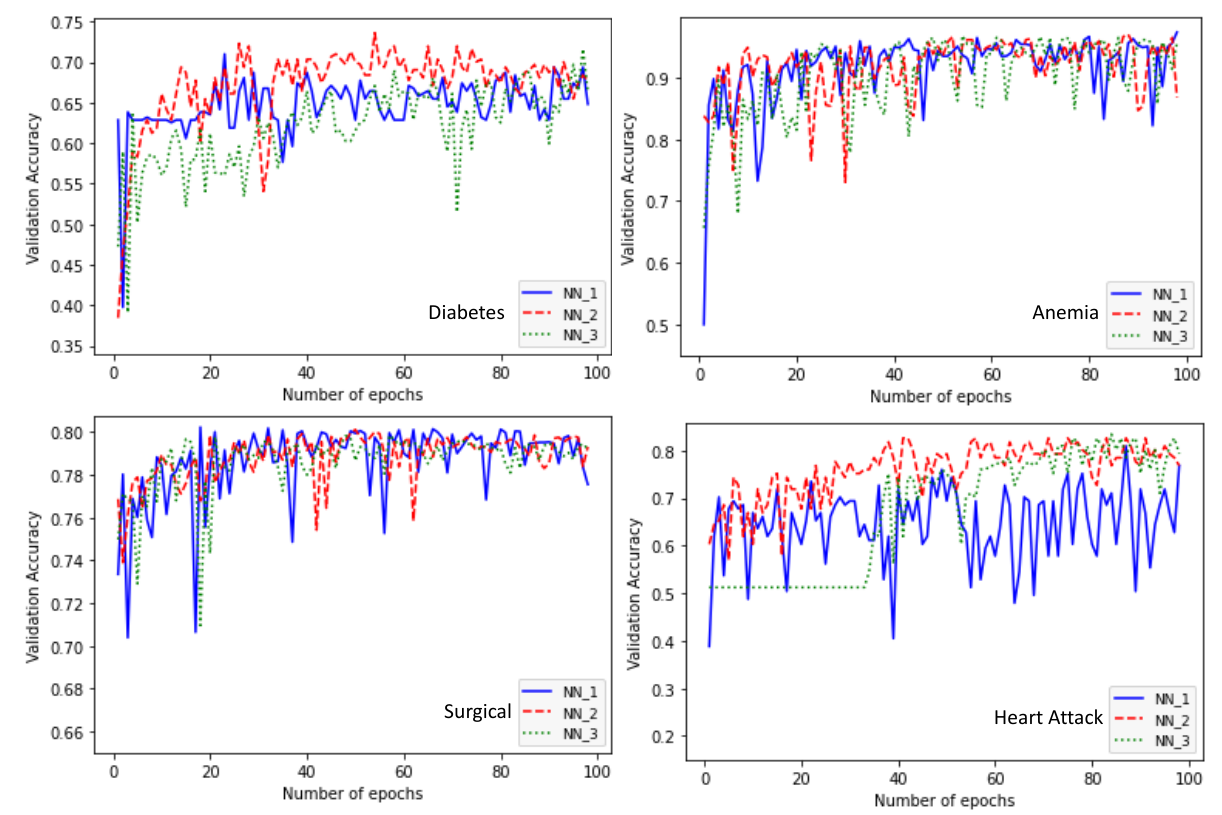
Figure 6. (First Experiment) Classification (i.e., validation) accuracy evaluated on the testing data as a function of the number of training epochs obtained by the three best neural network models: NN_1, NN_2, and NN_3 (Datasets: diabetes, anemia, surgical, and heart attack). The corresponding hyperparameter values, accuracy, and total time (in minutes) needed for the hyper-tuning for each data set are given in Tables 5 and 6.